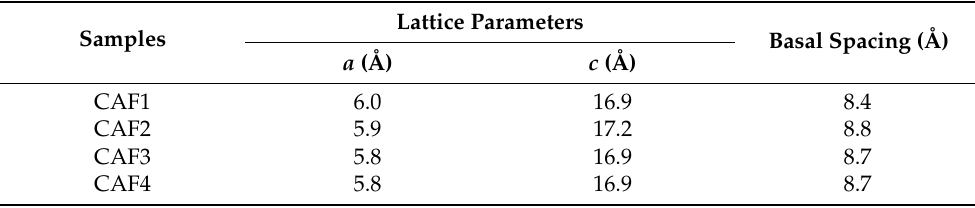
Table 2. Structural parameters of the synthesized